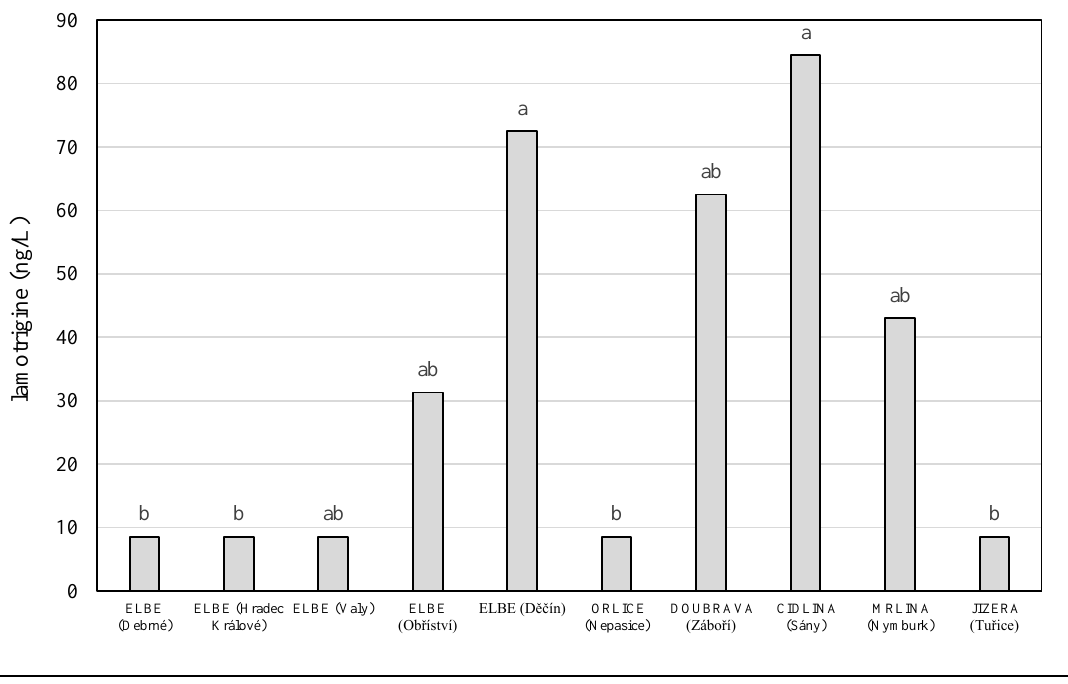
Figure 11. Median values of lamotrigine concentration at the sampled locations during the year 2021. Significant differences among the localities are indicated by different alphabetical superscripts ( p < 0.05).